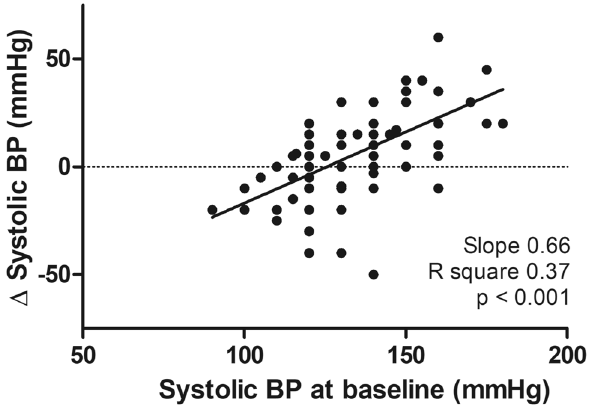
Figure 2. Change of systolic blood pressure (BP) from baseline to follow-up in dependence of baseline systolic blood pressure (linear regression